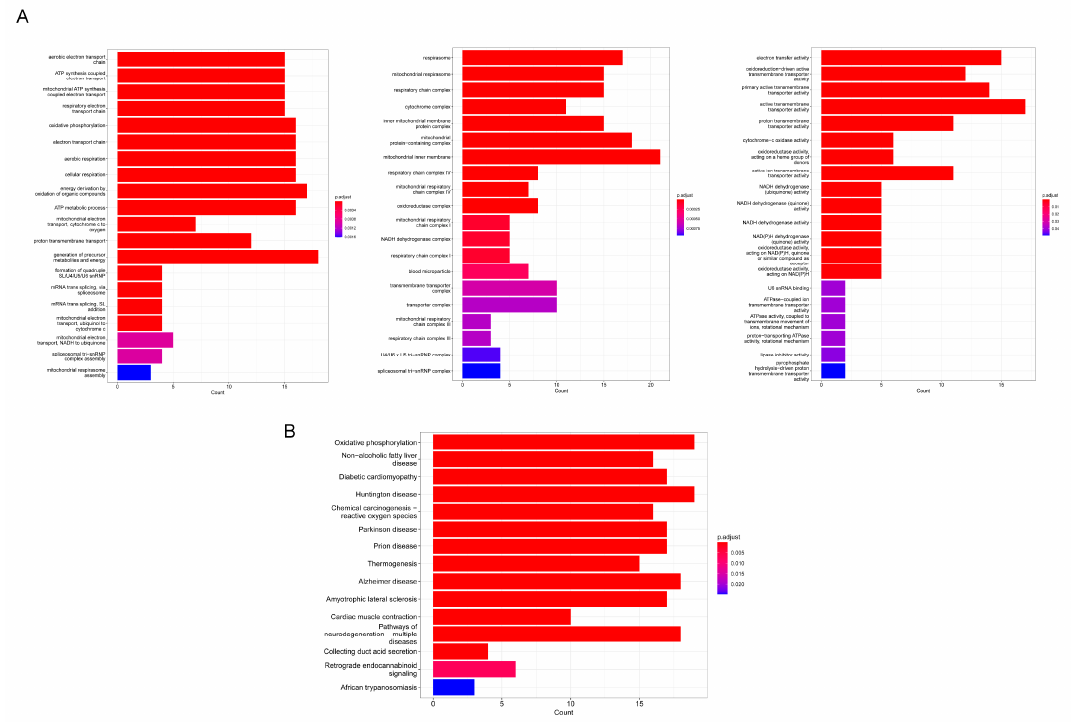
Figure 7. GO and KEGG analysis. ( A ) Bar graph of gene ontology functional annotations. ( B ) Bar graph of KEGG pathway enrichment analysis.